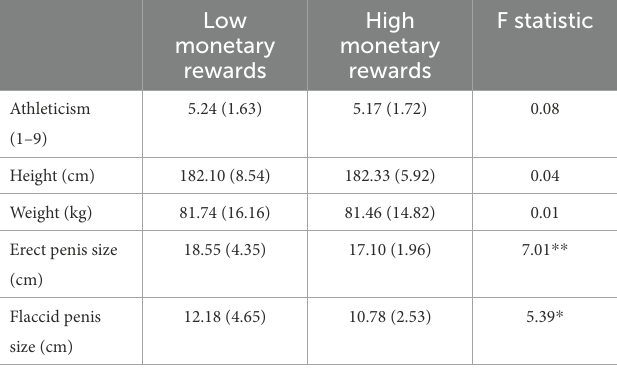
TABLE 2 Means (and standard deviations) across participant pools for athleticism, height, weight, and erect and flaccid penis size.